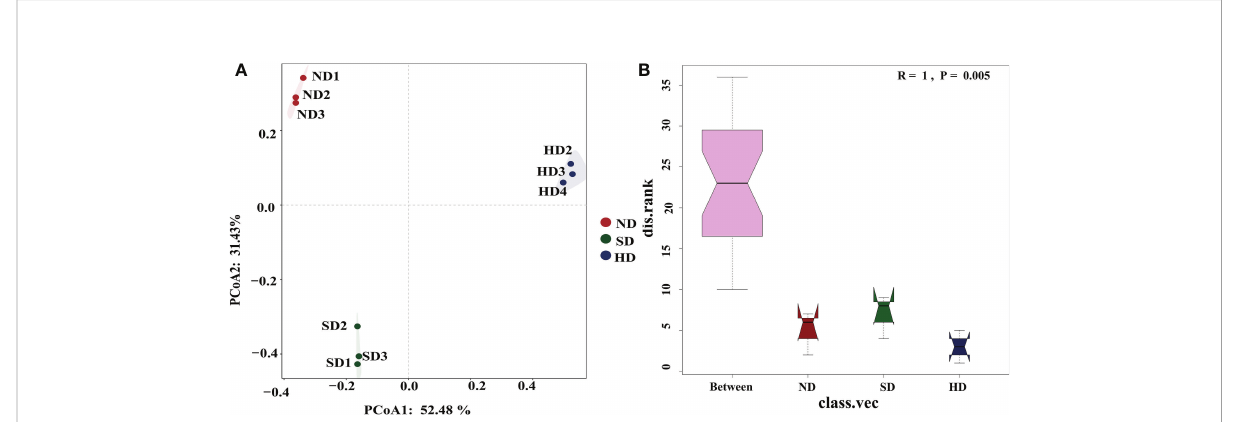
FIGURE 3 (A) Principal coordinate analysis (PCoA) plot of the fi rst two principal components based on soil Bacterial community compositions based on Bray-Curtis distance matrix at each area; (B) Bacterial community b -diversity differences; Note: R-value is between (-1,1), R-value > 0, indicating that the difference between groups is signi fi cant. R-value = 0, indicating that the difference within the group is greater than the difference between groups. The reliability of statistical analysis is expressed by P-value, and P < 0.05 indicates that the statistics are signi fi